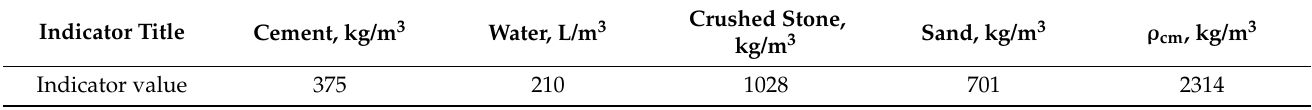
Table 7. Parameters of the composition of the concrete